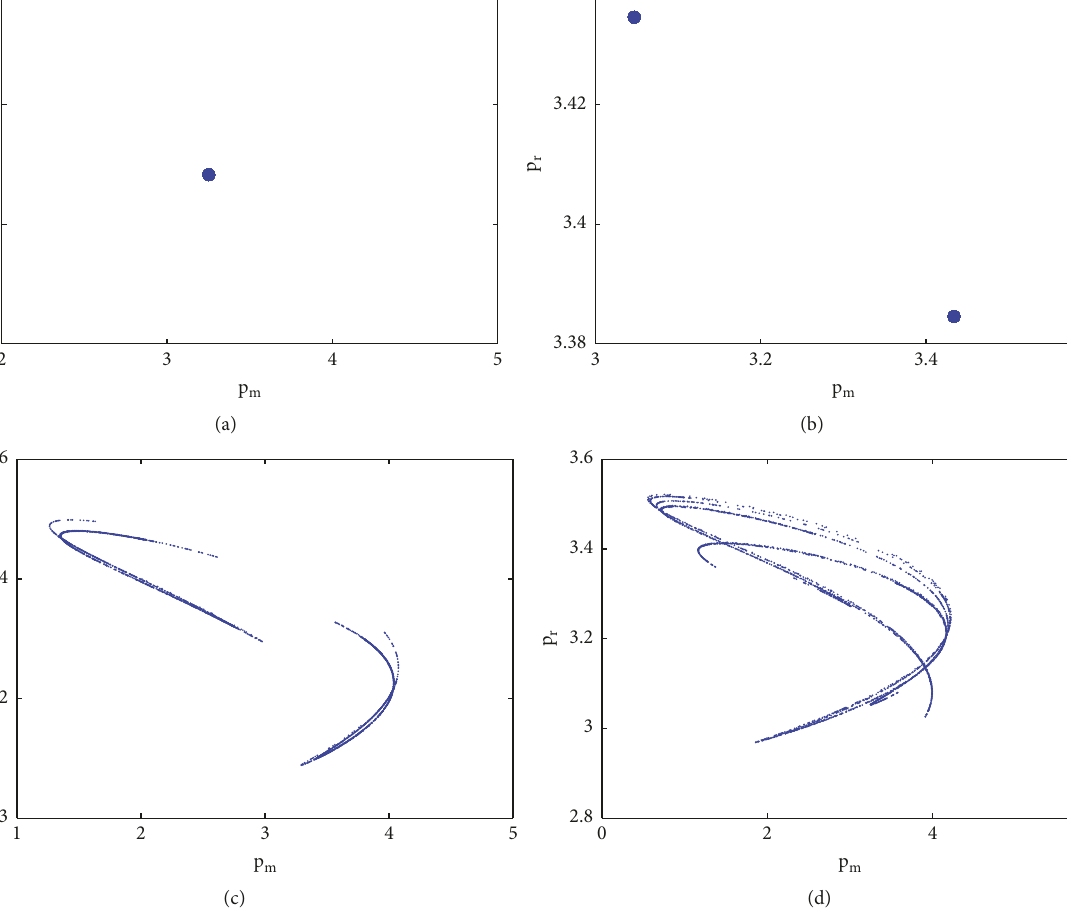
Figure 10: Attractors of the system get changes with the increase of 𝛼 1 : (a) 𝛼 1 = 0.1 . (b) 𝛼 1 = 0.3 . (c) 𝛼 1 = 0.4 . (d) 𝛼 1 = 0.43